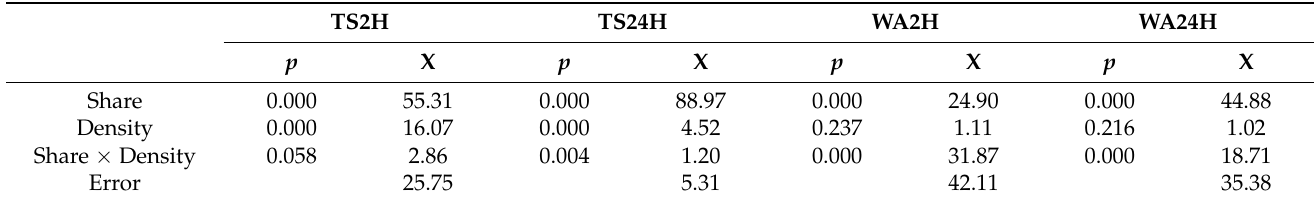
Figure 4. Thickness swelling and water absorption after 2 and 24 h of soaking in water. homogenous group by Tukey test ( α = 0.05). Table 4. MANOVA results of physical properties of particleboards. Table 4. MANOVA results of physical properties of